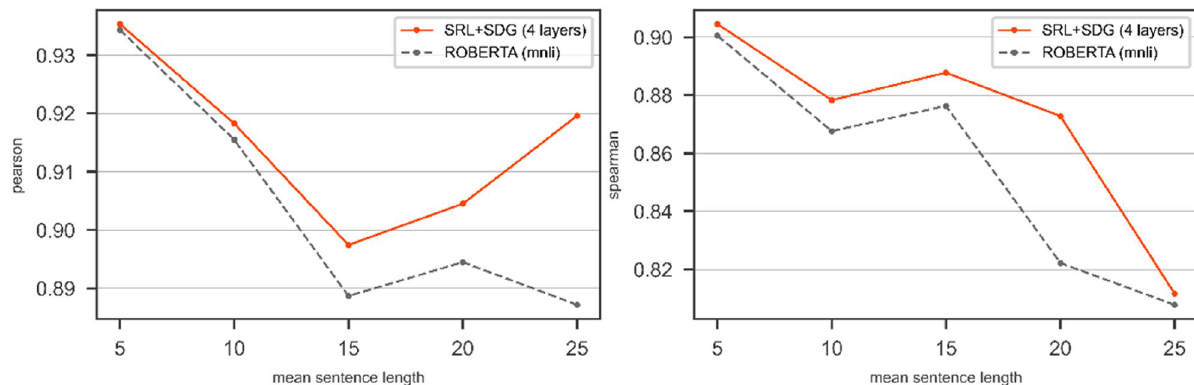
Figure 9. The results of RoBERTa and the DGNN on top of the RoBERTa over SRL + SDG on SICK/Test in terms of Pearson (left) and Spearman (right). The pair of sentences with mean length is categorized in the window [ − 2, 2]